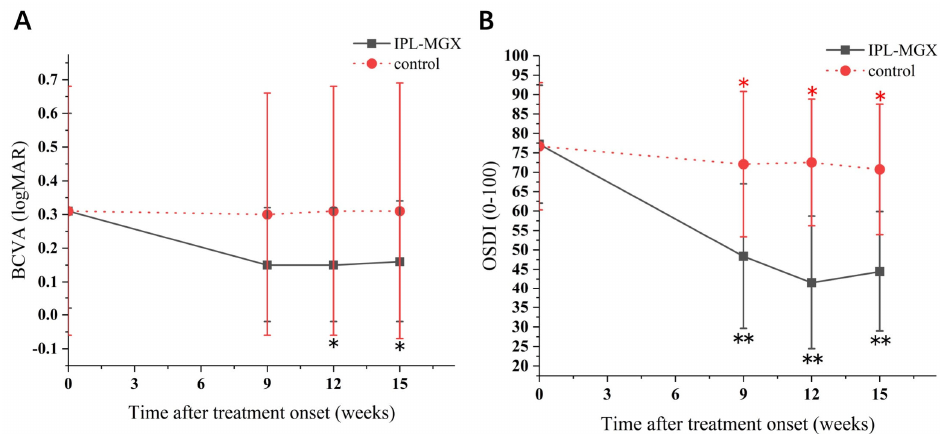
Figure 2. Time course of Snellen best–corrected visual acuity (BCVA) and Ocular Surface Disease Index (OSDI) score in the intense pulsed light (IPL)–meibomian gland expression (MGX) and control groups. ( A ) Changes of BCVA before and after treatment. ( B ) Changes of OSDI score before and after treatment. All follow–up assessments were compared to baseline (time 0) values (* p < 0.05, ** p < 0.001).